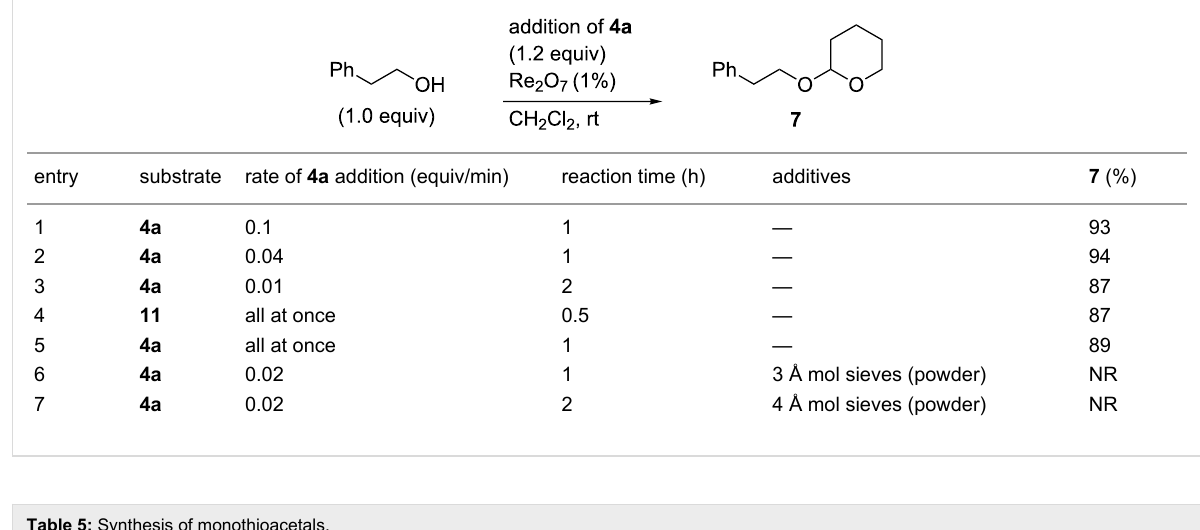
Table 5: Synthesis of